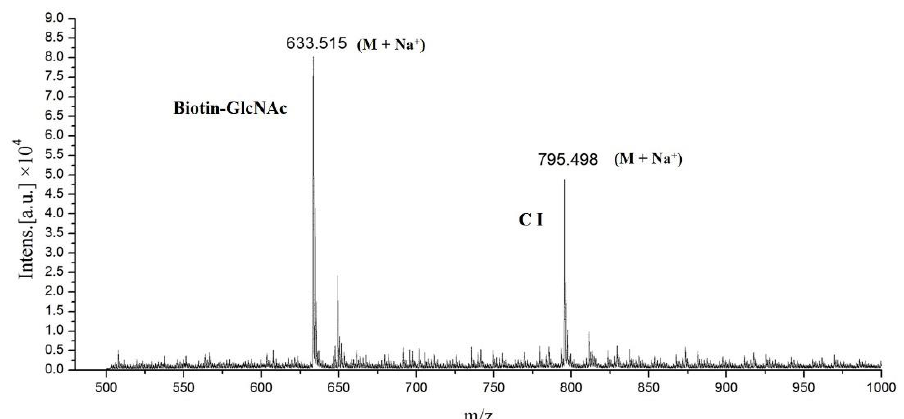
Figure 2. MS analysis of UHFA-based solid-phase sequential OPME synthesis of Compound I (C I).